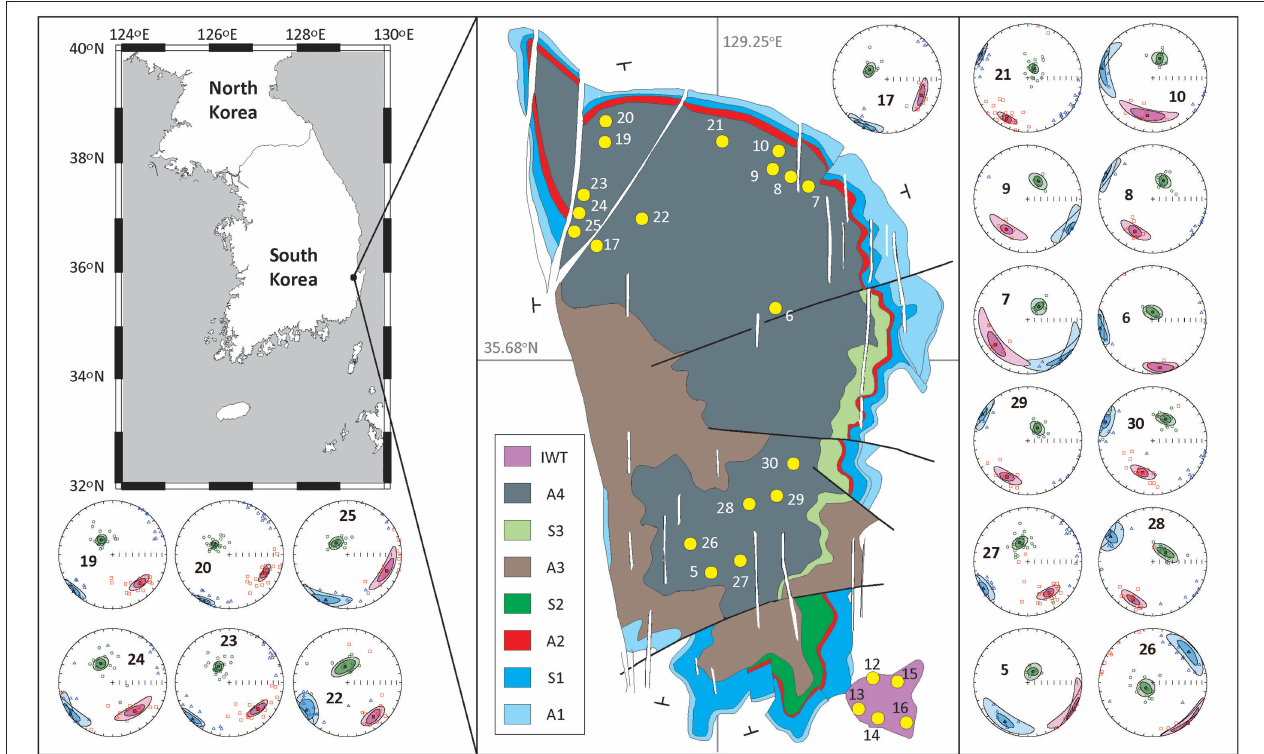
FIGURE 1 | Map of Chisulryoung Volcanic Formation (CVF) (after Park, 1990) and stereographic projections of anisotropy of magnetic susceptibility (AMS) data for 19 sites in A4 member. The inset was generated from the “Generic Mapping Tools (GMT)” version 5.2.1 distributed from the School of Ocean and Earth Science and Technology, University of Hawaii at Manoa (http://gmt.soest.hawaii.edu/). For each stereographic projection, eigenvectors are displayed on an equal area plot using the lower hemisphere projection with the convention that maximum ( k 1 ), intermediate ( k 2 ), and minimum ( k 3 ) susceptibility are represented as red squares, blue triangles, and green circles. Confidence ellipses were calculated on the basis of the Jelinek method (inner ellipses with darker colors) and the site parametric bootstrap statistics (outer ellipses with brighter